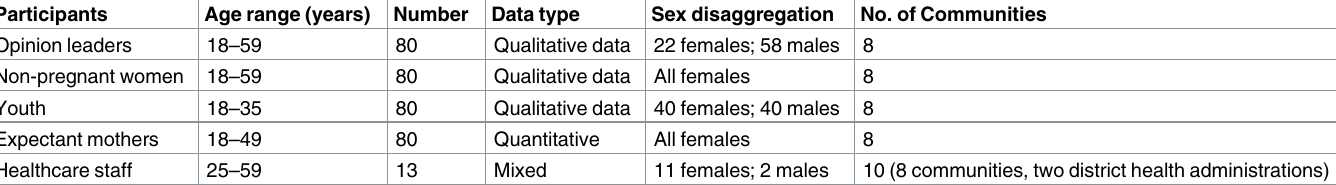
Table 1. Composition of participants